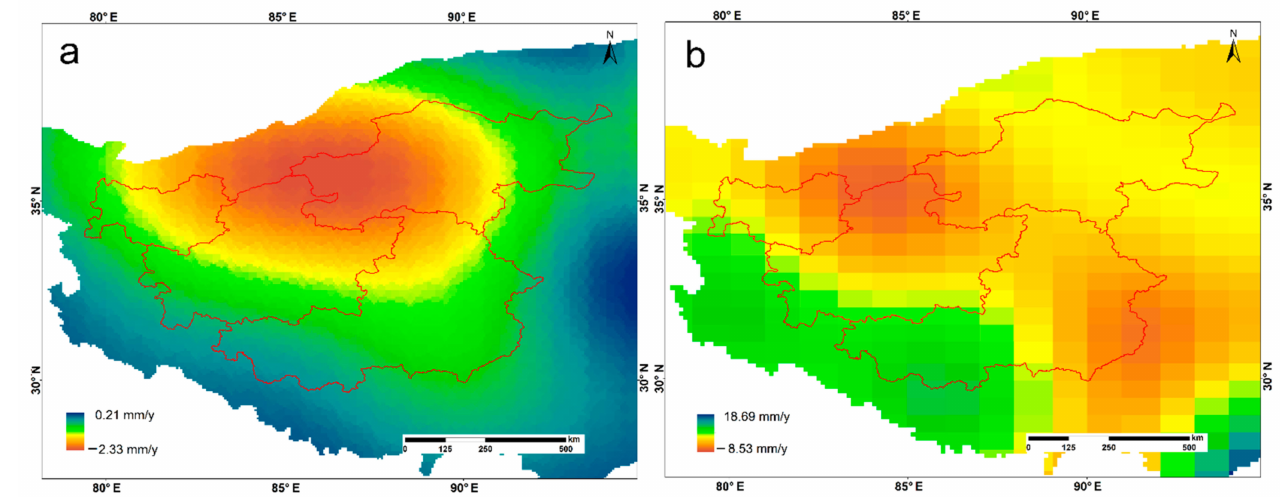
Figure 5. The changing trend in ALD and soil moisture. ( a ) ALD; ( b ) soil moisture. There was a sizeable spatial difference in the changes of SM, the decreasing SM was